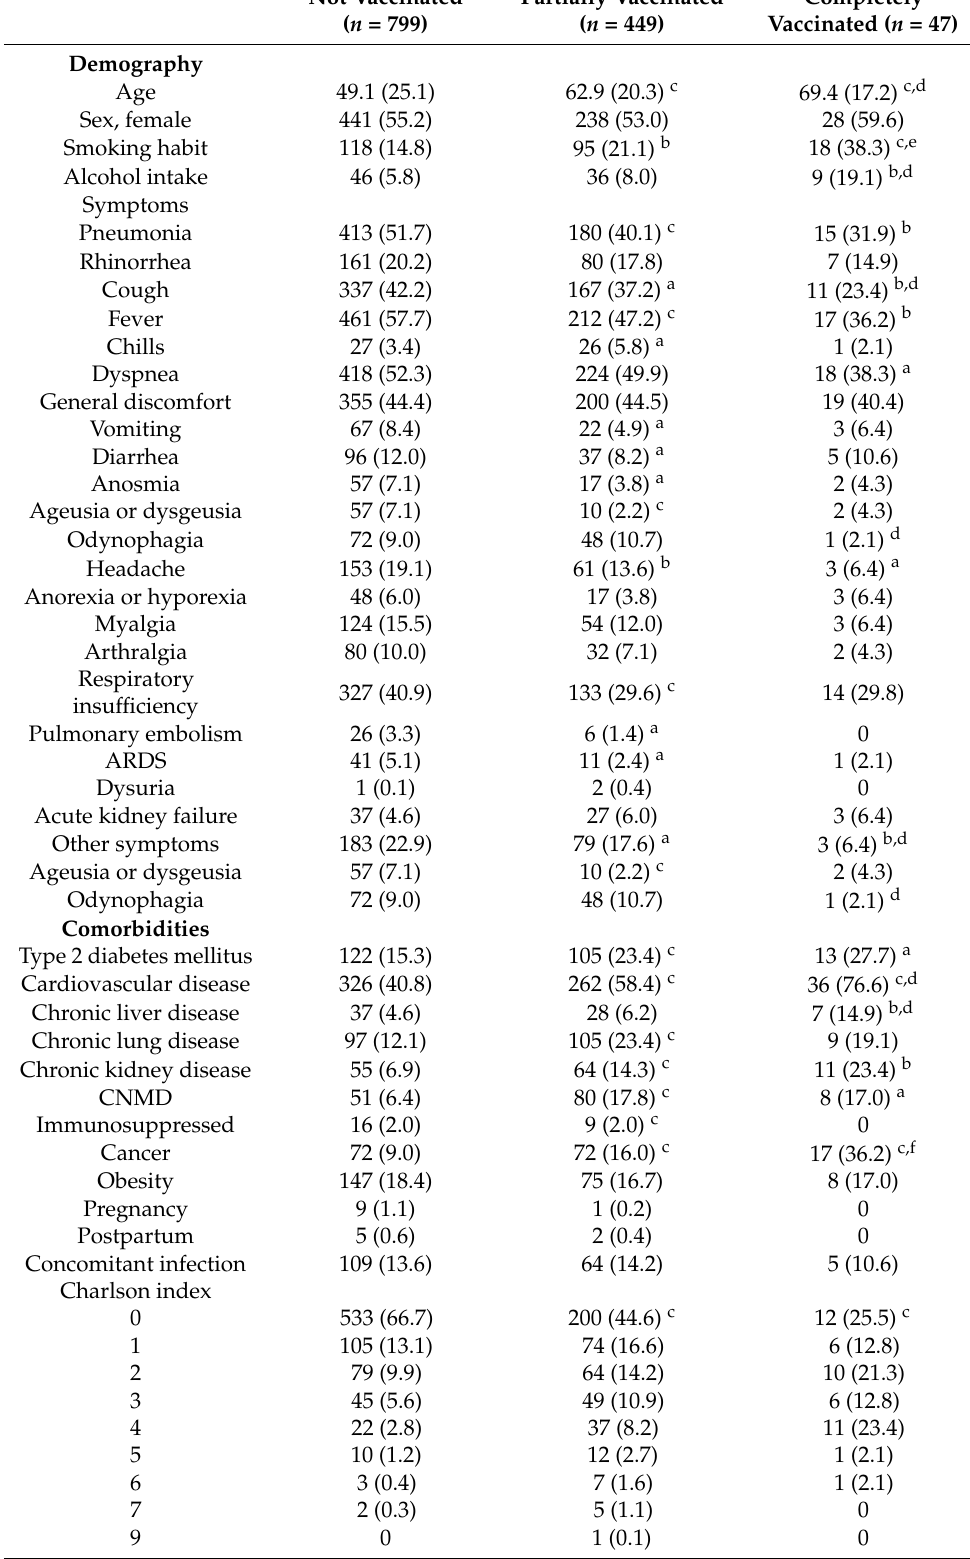
Table 1. Demographic and clinical characteristics of the patients